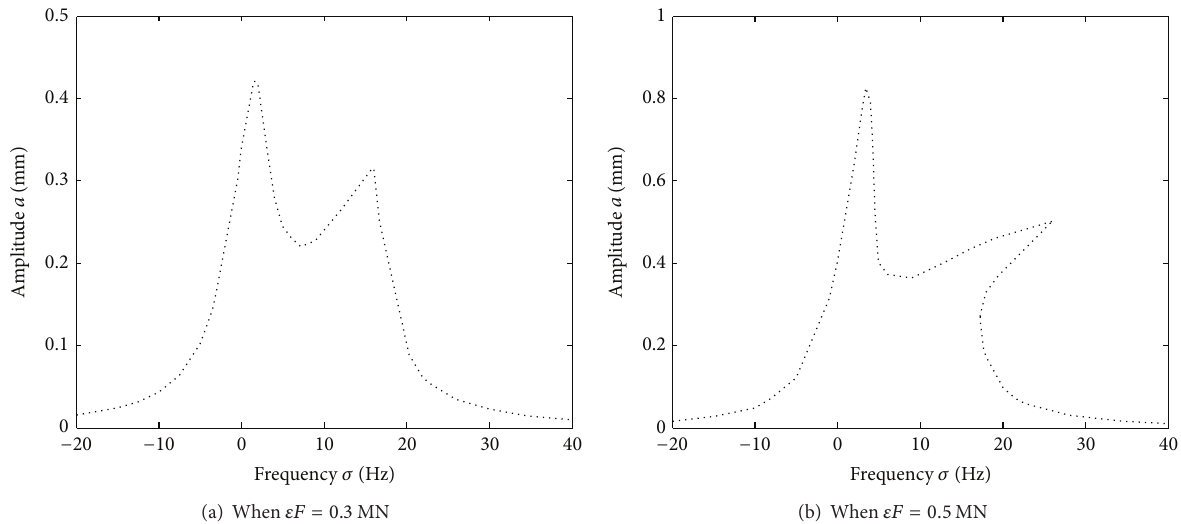
Figure 8: Curve of inner resonance amplitude frequency in horizontal direction with disturb amplitude 𝜀𝐹 .